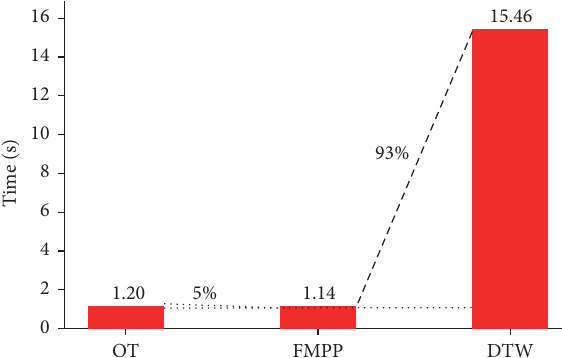
Figure 10: The simulation results of the time consumed by FMPP and comparison